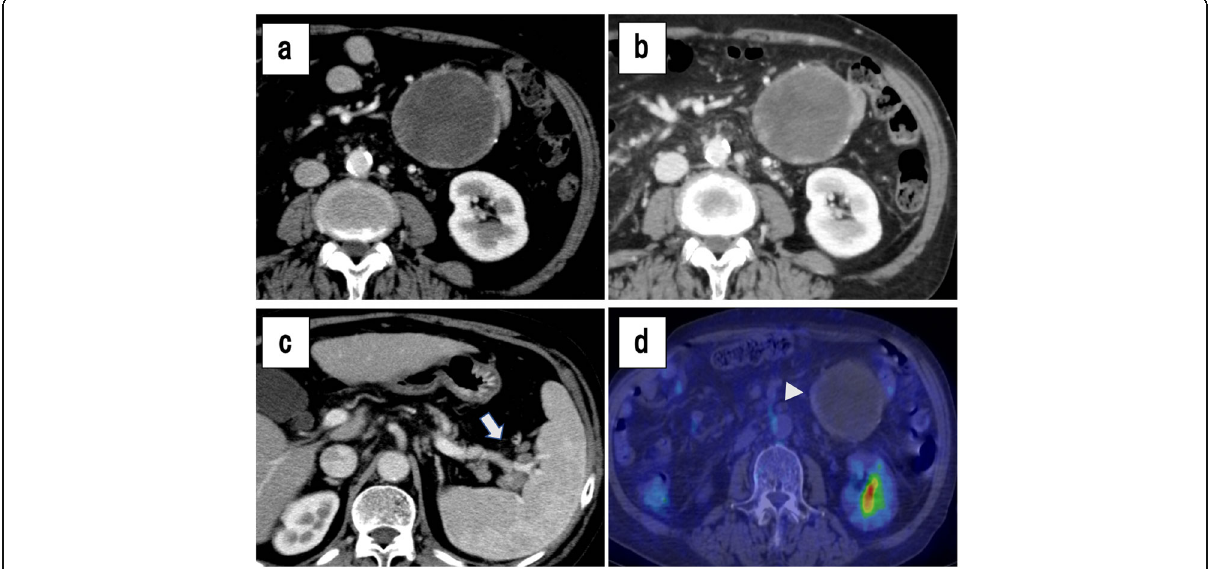
Fig. 1 Abdominal contrast-enhanced computed tomography (CT) findings ( a – c ). a A well-defined, mixed-density, round tumor with a maximum diameter of 77 mm, adjacent to the upper jejunum. b The tumor was accompanied by calcification at part of the border. c Diffuse lymphadenopathy was detected at the paraaortic, splenic artery region, and splenic hilum area (arrow). d (18)F-FDG PET-CT showed slight accumulation (SUVmax 1.5 – 2.0) along the tumor border, corresponding to the calcified portion